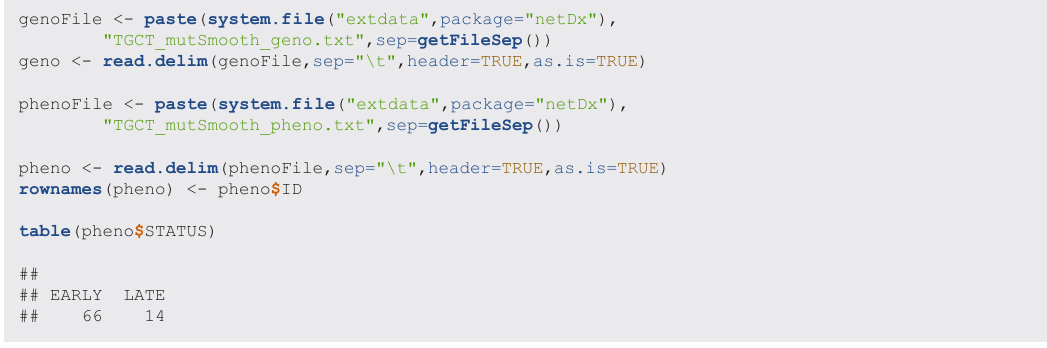
Smooth mutations over a gene interaction network. The gene-gene interaction network used in this example contains high-confidence cancer-specific interactions 18 . This specific network effectively clusters tumour samples of patients, distinguishing them by tumour type and time of survival. This is a binary symmetric network.